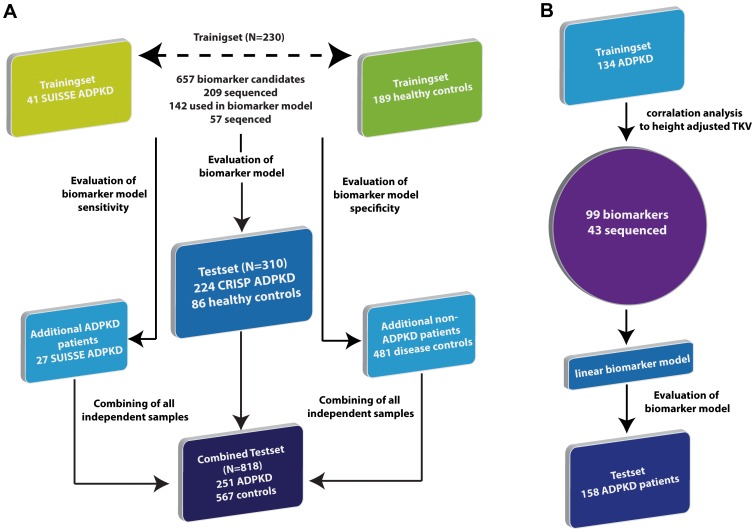
Usage of samples and flow of information.A, Identification and validation of diagnostic biomarkers and biomarker models. 41 cases of ADPKD were compared to 189 healthy controls, which resulted in the definition of 657 potential biomarkers. Of these, 142 were employed in an SVM-driven biomarker model, ADPKD_142. All potential biomarkers and the biomarker model were evaluated in a test set of 310 blinded samples that consisted of 224 samples from patients with ADPKD and 86 healthy controls. The ADPKD_142 model was further validated using additional ADPKD samples from the SUISSE ADPKD study (n = 27) and using controls samples of patients with a variety of different renal and systemic diseases. B, Identification and validation of biomarkers and biomarker model for disease severity. CE-MS data from 135 urine samples from patients with ADPKD were correlated with height adjusted TKV (htTKV), resulting in the identification of 99 potential biomarkers associated with htTKV. Employing linear combination, a biomarker models indicative of disease severity was established. This biomarker model was subsequently tested in a validation set consisting of 153 ADPKD samples.